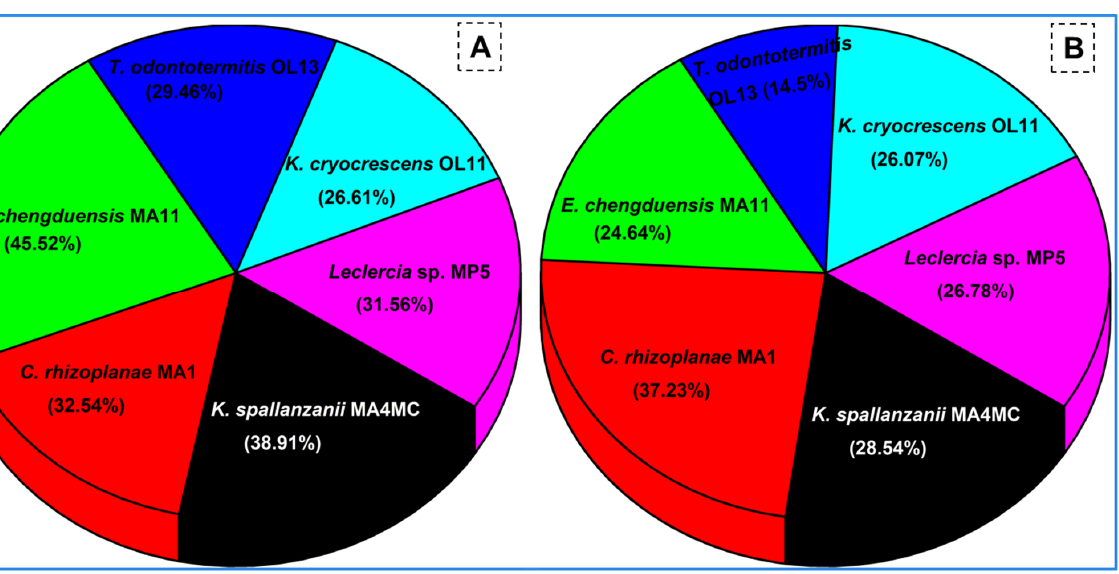
Figure 7. Substrate degradation capability of the potential isolates on rice straw ( A ), and corn stover ( B ) used as sole sources of carbon.